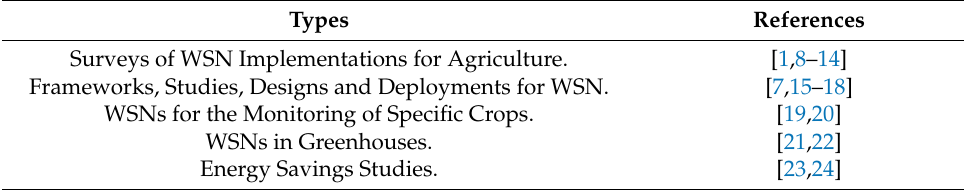
Table 1. Previous studies regarding the use of WSNs in soil monitoring for agriculture.